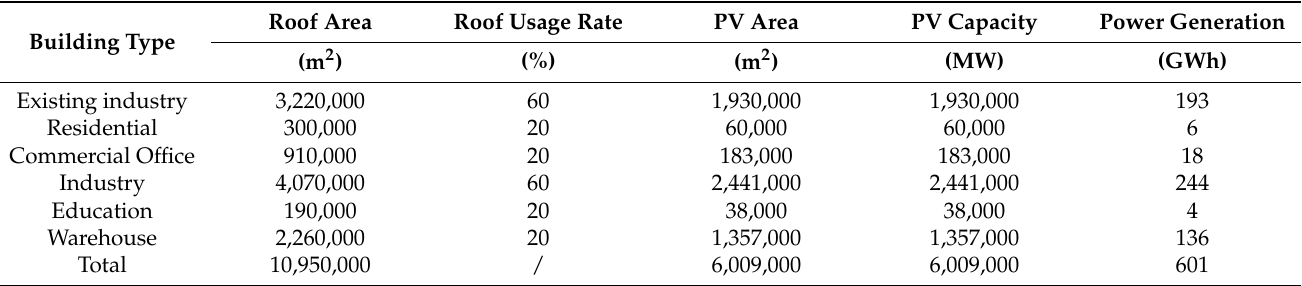
Table 10. PV layout plans for different types of buildings by 2030 (40 MW in existence).